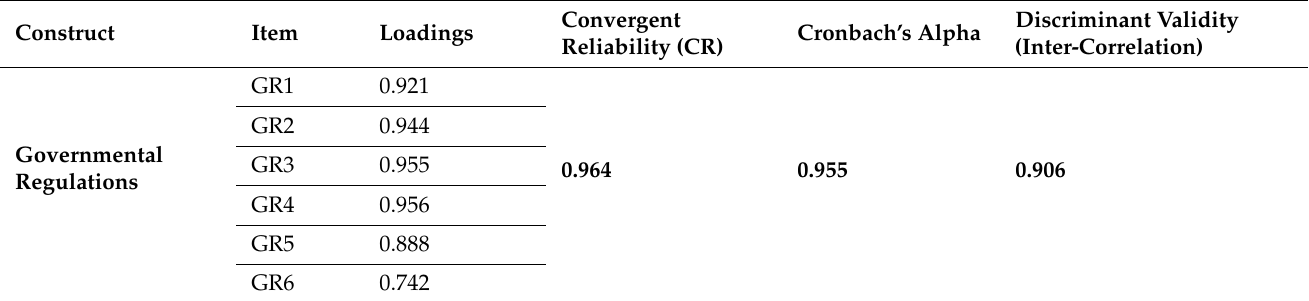
Table A4. Reliability & Validity of Governmental